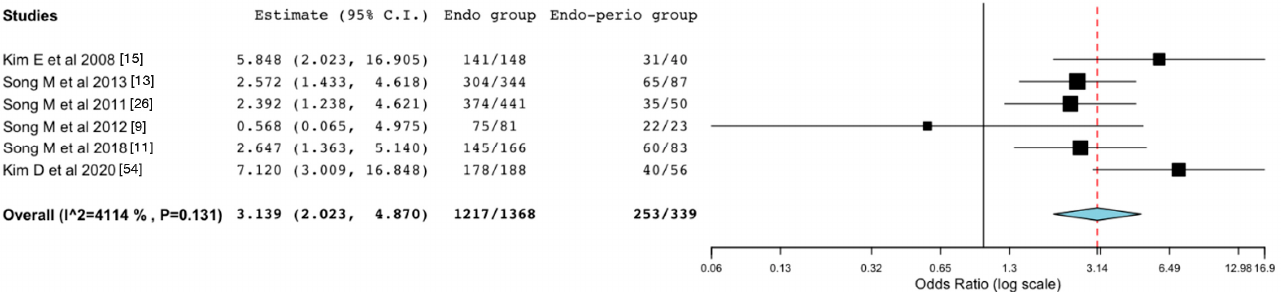
Figure 2. Forest plot of odds ratio of success in endodontic (endo) group compared to the endodontic-periodontal (endo- perio) group. Confidence interval (CI).